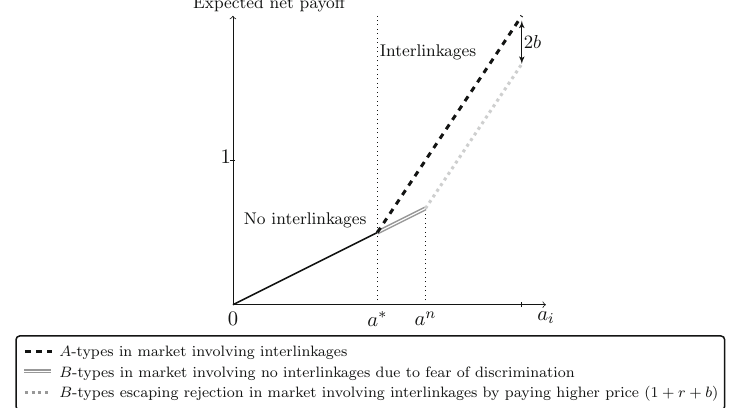
Fig. 4 Ability levels and choice of market (strategic interaction vs. no strategic interaction) with discrimi-